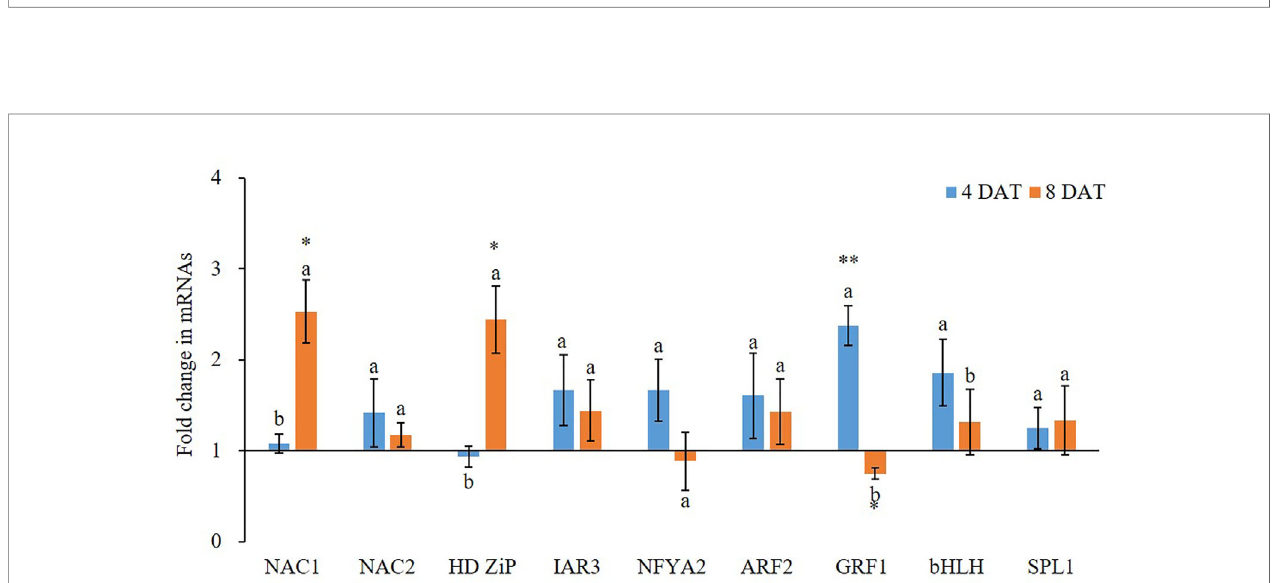
FIGURE 3 | Fold change of miRNA target gene expression between low K + treatment and the controls at 4/8 days after transfer day (DAT). Error bars represent S.E. (n = 3). Highly signi fi cant difference was marked as ** to represent a p value < 0.01 and as * to represent a p value < 0.05 between low K + treatment and the controls. The different letters on the bars indicate signi fi cant differences of fold change of miRNA target expression between 4 and 8 DAT according to the LSD test (P =